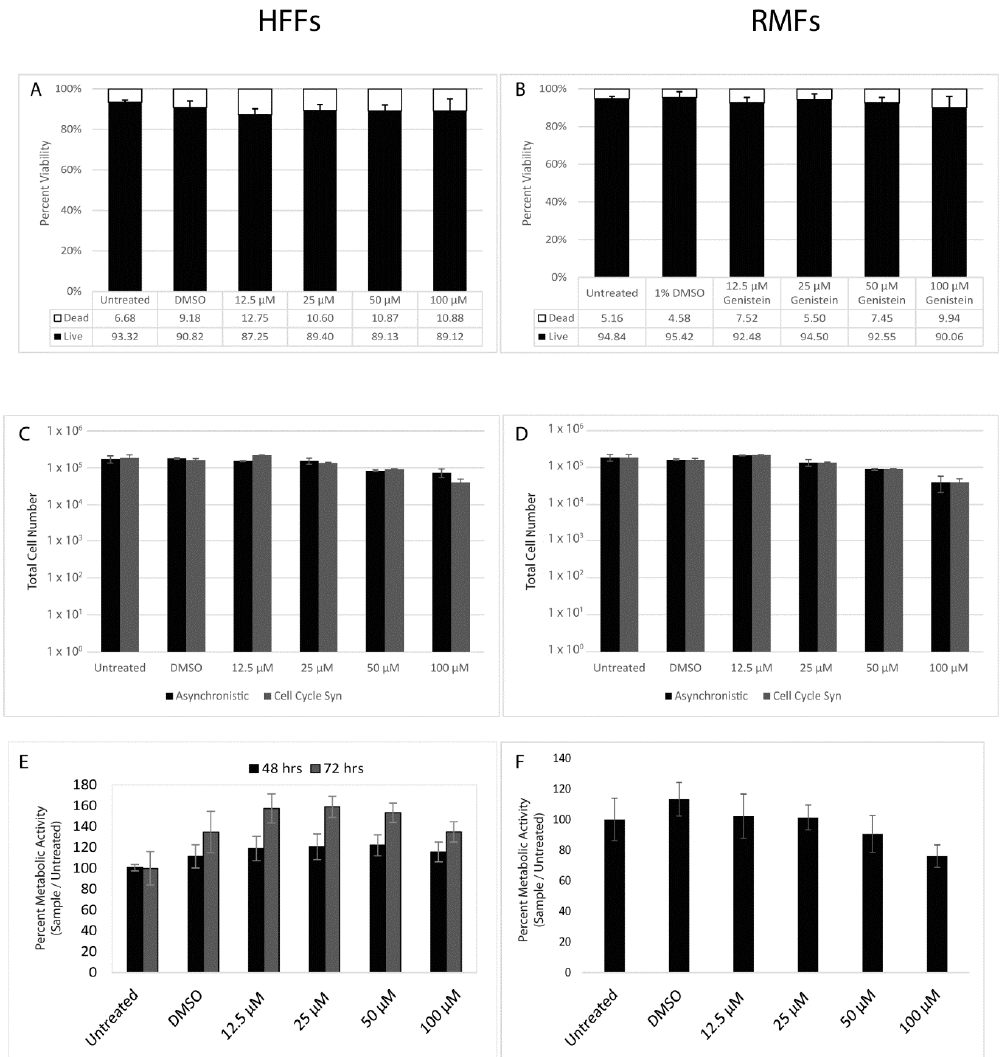
Figure 1. Cytotoxicity of genistein in human foreskin fibroblasts (HFFs) and Rhesus macaque foreskin fibroblasts (RMFs). Cells were left untreated (negative control) or treated with either 0.1% dimethyl sulfoxide (DMSO) (experimental control) or increasing concentrations of genistein. After 48 h, HFFs ( A ) and RMFs ( B ) were collected and assayed for live vs. dead cells via trypan blue dye exclusion. HFFs ( C ) and RMFs ( D ) were kept as an asychronous population or growth was synchronized via overnight serum-starvation prior to genistein treatment. Cells were collected and the total cell numbers counted after 48 h. HFFs ( E ) and RMFs ( F ) were serum-starved overnight, then genistein-treatments were added and cells were incubated for 48 h ( E ) or 72 h ( E , F ), and then assayed for metabolic activity via MTS